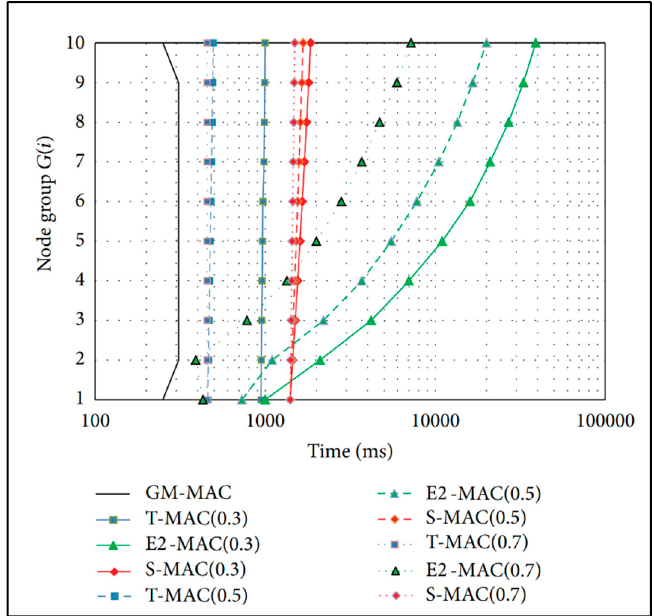
Figure 1. Average active time of sensor nodes.